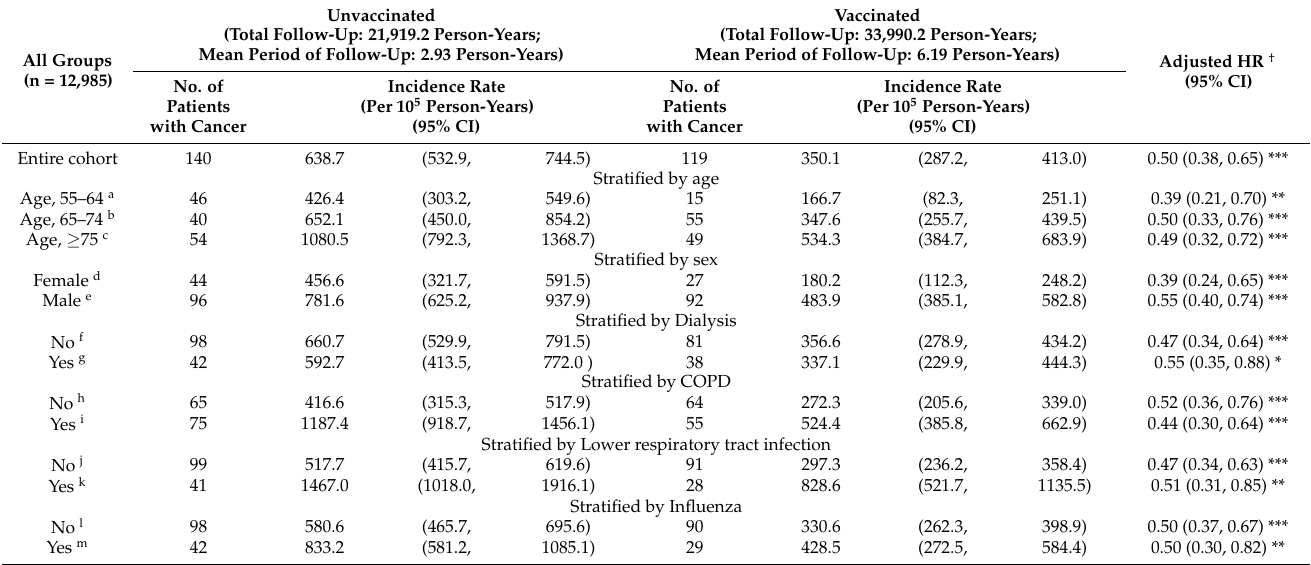
Table 2. Risk of lung cancer among unvaccinated and vaccinated groups in the study cohort.